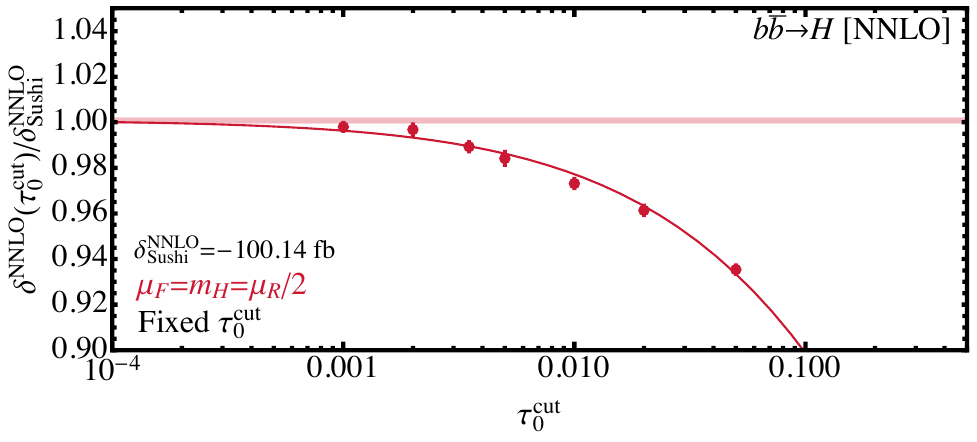
Figure 2 . Comparison of the NNLO coefficient obtained with MCFM and the equivalent prediction from SusHi . Shown are the results obtained for a selection of choices of the slicing parameter τ cut and a two-parameter fit to the power corrections. The shaded band corresponds to the uncertainty on the extracted τ cut → 0 limit from the 0